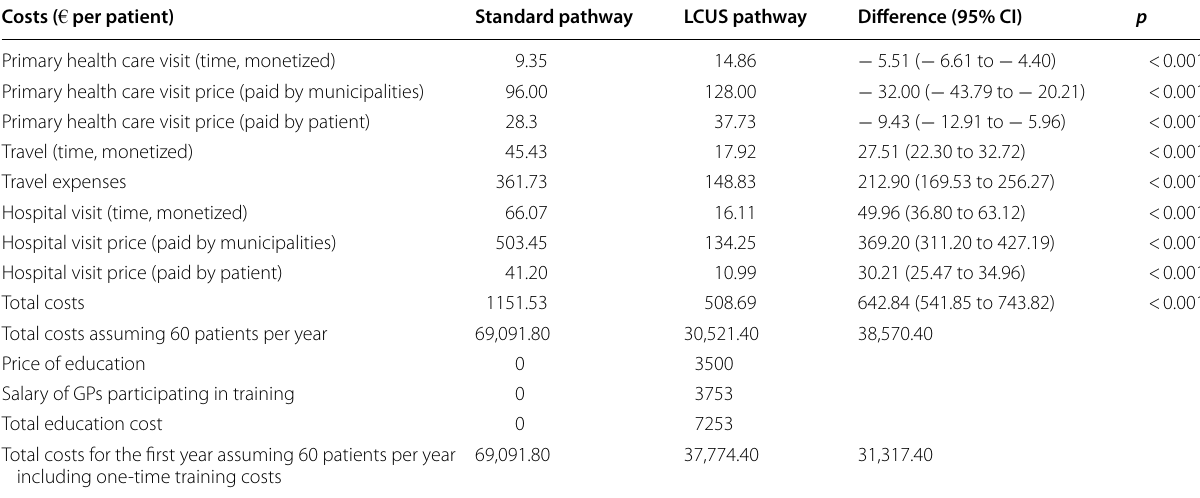
Table 4 Cost calculator demonstrating the cost-minimization modeling in real-life including educational